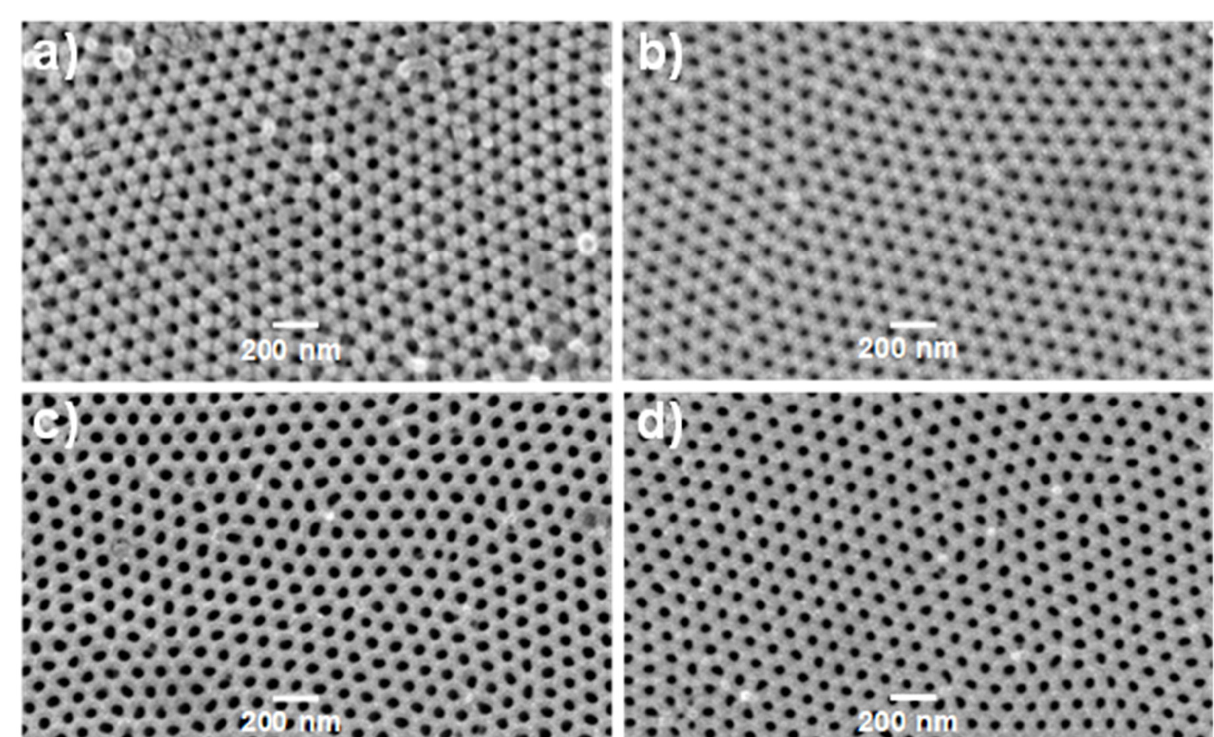
Figure 2. SEM top surface images of samples ( a ) Ox(A), ( b ) Ox(A)/SiO 2 , ( c ) Ox(B), and ( d ) Ox(B)/SiO